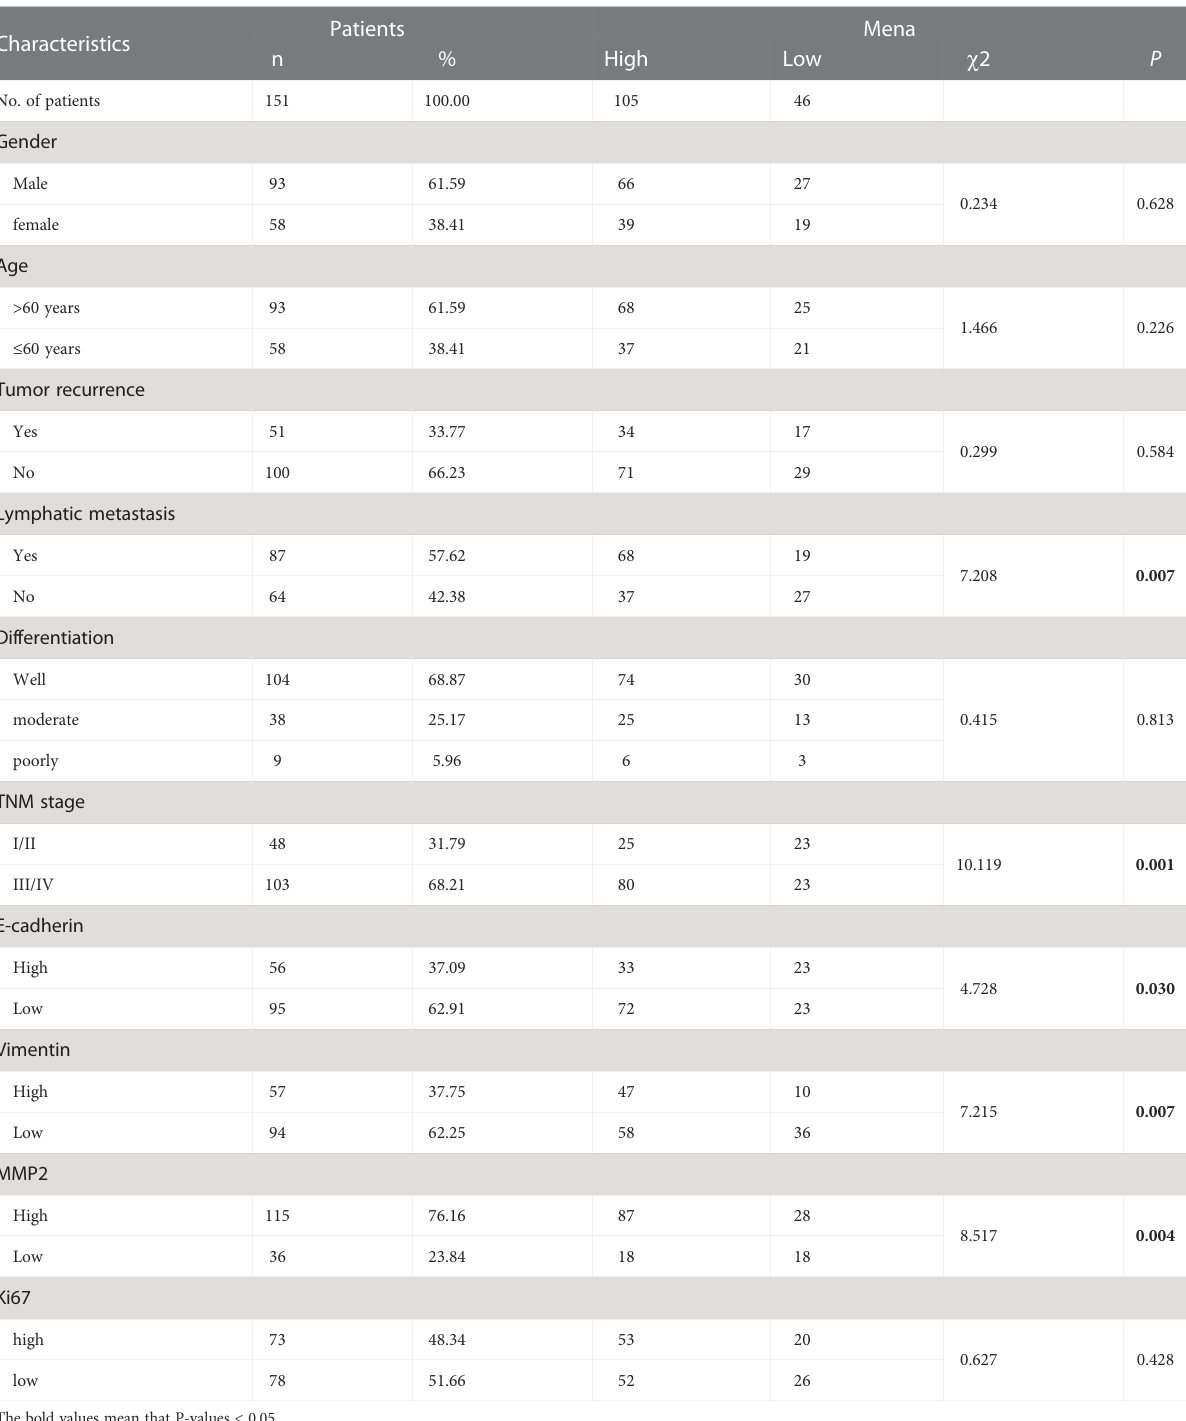
TABLE 1 The correlation between Mena expression and clinicopathological characteristics in